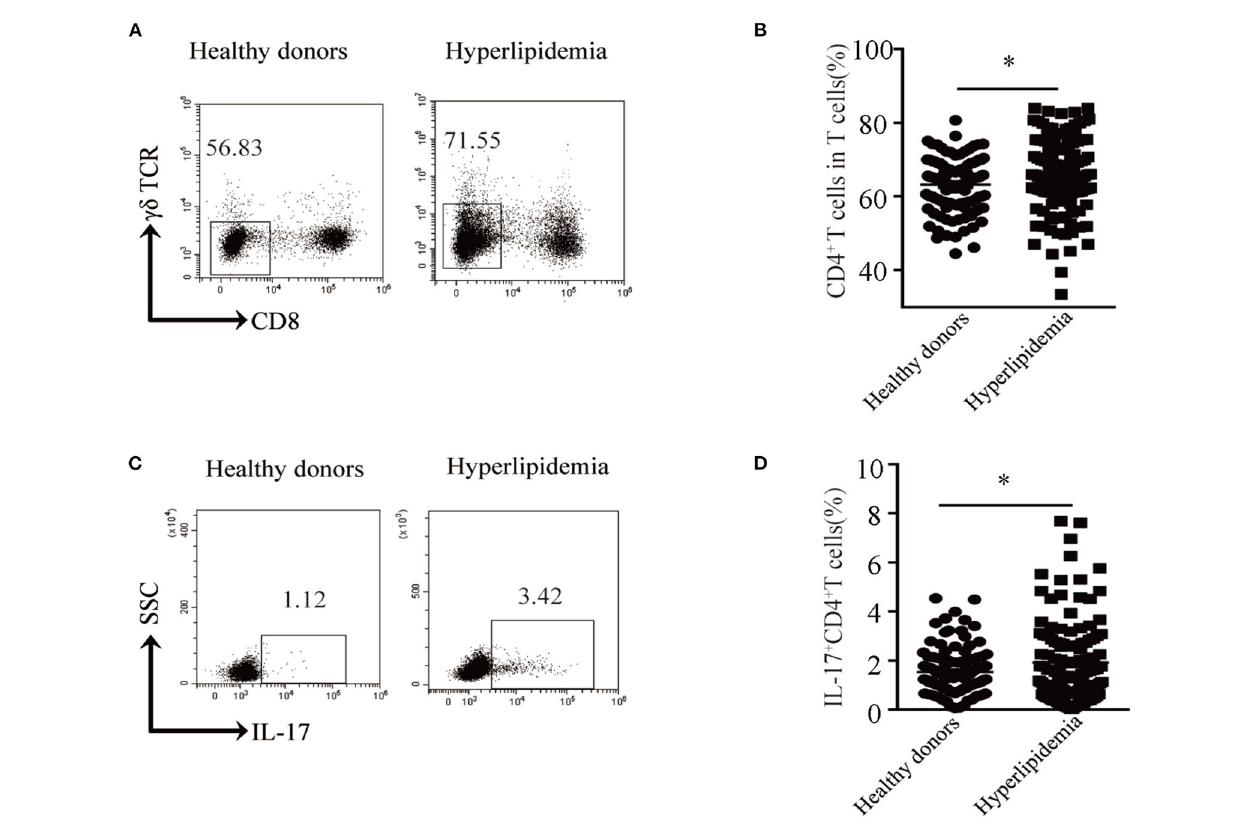
FIGURE 1 | Th17 cell percentage in peripheral blood of hyperlipidemic patients. (A) Dot plots of surface molecule staining for CD8 − γδ TCR − T cells (i.e., CD4 + T cells) gating on CD45 + CD3 + cells. (B) CD4 + T cell percentage in CD45 + CD3 + T cells. Cumulative results from 129 patients with hyperlipidemia and 110 healthy donors are shown. (C) Dot plots of intracellular staining of IL-17 in CD4 + T cell. (D) Th17 cell percentage in CD4 + T cells. Each dot in (C,D) represents one patient. * p < 0.05.